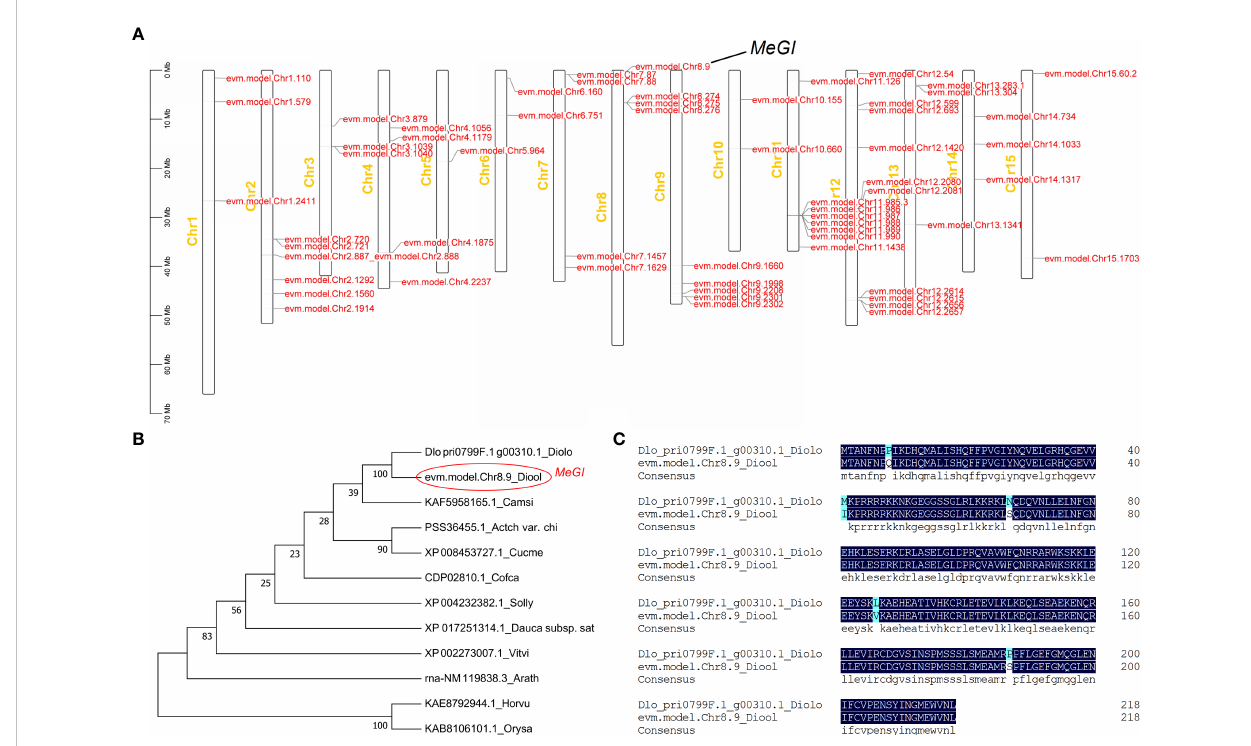
FIGURE 1 Location of the HD-ZIP transcription factor family and phylogenetic analyses of the MeGI protein. (A) Location of the HD-ZIP transcription factor family. (B) Phylogenetic analysis of the MeGI protein with its optimal homologues from other species. Diolo, Diospyros lotus ; Diool , Diospyros oleifera; Camsi, Camellia sinensis ; Actch var. Chi, Actinidia chinensis var. Chinensis ; Cucme, Cucumis melo ; Cofca, Coffea canephora ; Solly, Solanum lycopersicum ; Dauca subsp. Sat, Daucus carota subsp. Sativus ; Vitvi, Vitis vinifera ; Arath, Arabidopsis thaliana ; Horvu, Hordeum vulgare , and Orysa, Oryza sativa. (C) Sequence alignment analysis of the MeGI protein from D . oleifera and D . lotus. Diolo , Diospyros lotus; Diool , Diospyros oleifera. .